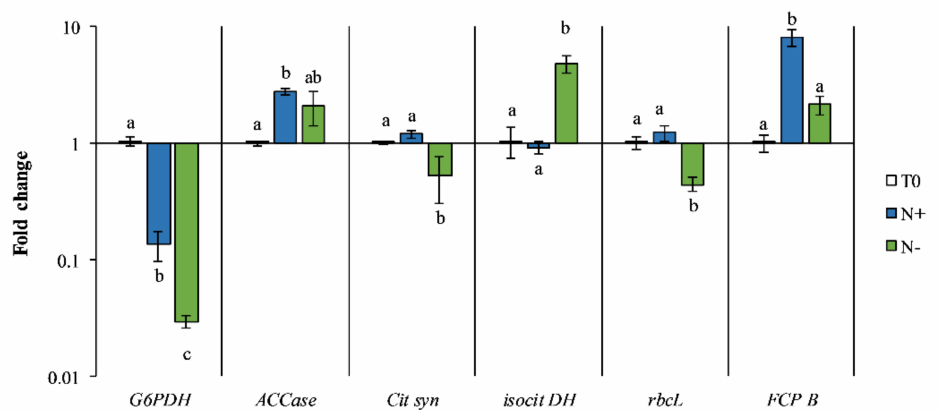
Figure 9. Relative gene expression of genes related to lipid biosynthesis (glucose-6-phosphate dehy- drogenase ( G6PDH ), acetyl-coenzyme A carboxylase ( ACCase ), citrate synthase ( Cit syn ), and isoc- itrate dehydrogenase ( isocit DH )) and photosynthetic activity (ribulose-1,5-bisphospate carboxy- lase/oxygenase (large subunit) ( rbcL ) and fucoxanthin-chlorophyll a/c binding protein B ( FCP B )) in P. tricornutum under initial culture conditions (T0, white bars) and after 15 days of cultivation under standard conditions (N+, blue bars) and starvation conditions (N − , green bars). Values are the mean ± SEM ( n = 3) with standard deviations. Statistical differences ( p < 0.05) between groups are indicated by different